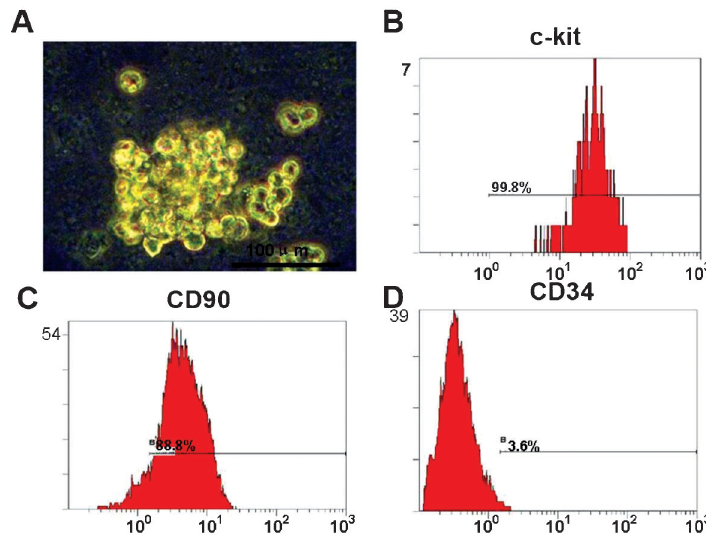
Figure 4. Identification of hepatic oval cells (HOCs). A , HOCs in suspension culture were immunostained with an anti-c-kit antibody. Positive cells appear as yellow fluorescence by fluorescence microscopy. B - D , The percentage of c-kit ( B ), CD90 ( C ), or CD34 ( D ) positive HOCs (passage 4) was evaluated by flow cytometry analysis. x-axis: number of cells; y-axis: